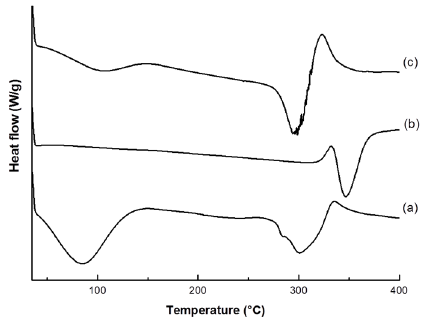
Figure 3. Differential scanning calorimetry analysis of the pure cyclodextrin ( a ), of the VC-IP ( b ), and of the sample VC-IP@cyclodextrin ( c ).